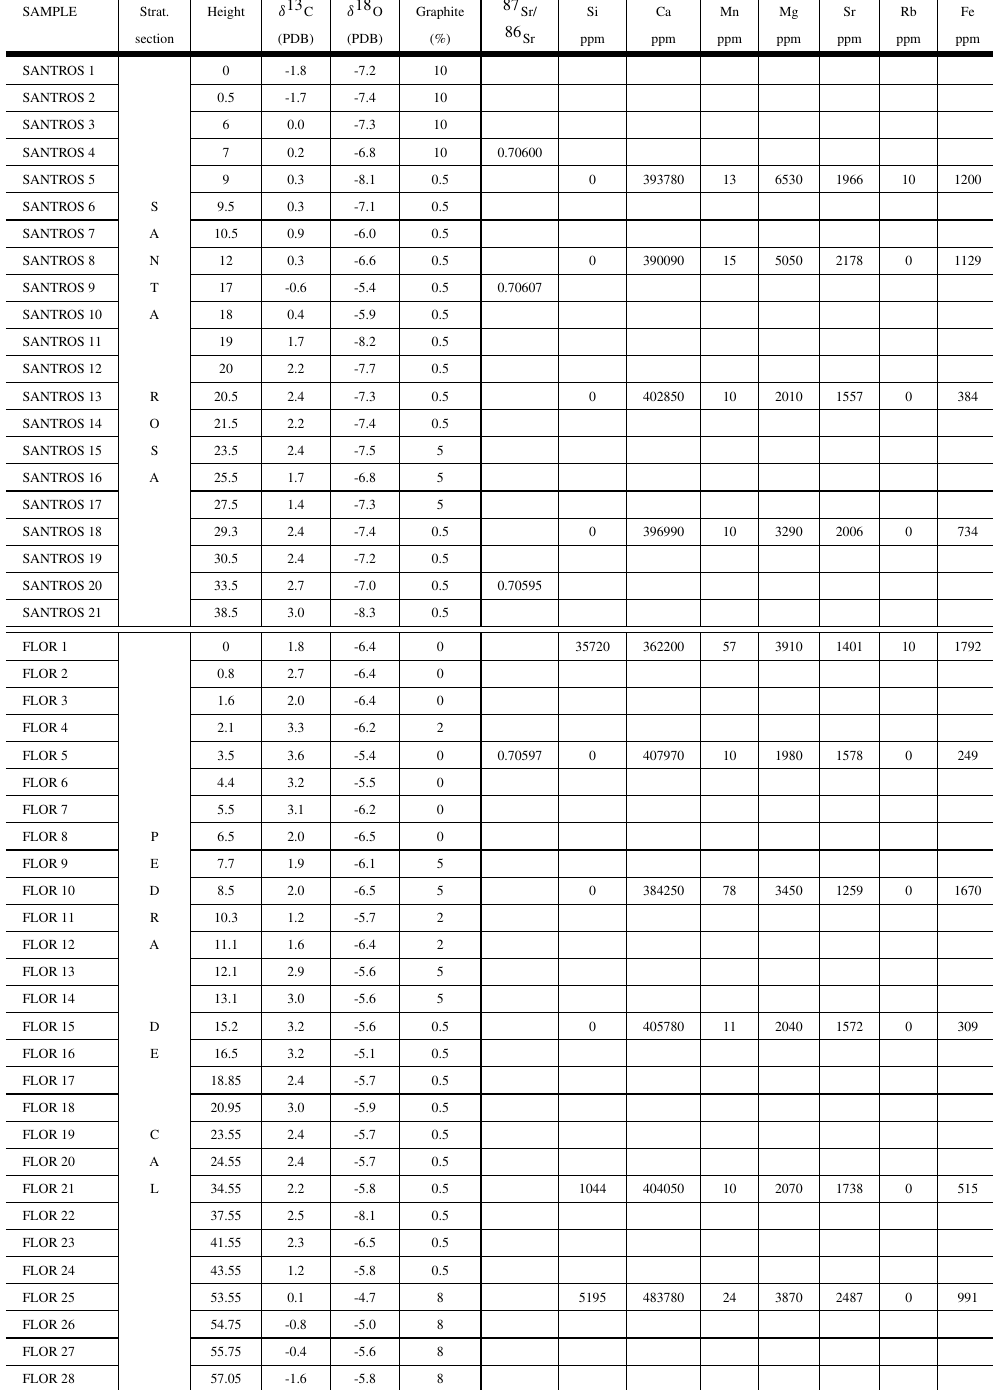
Geochemical analyses of representative samples of the studied marble